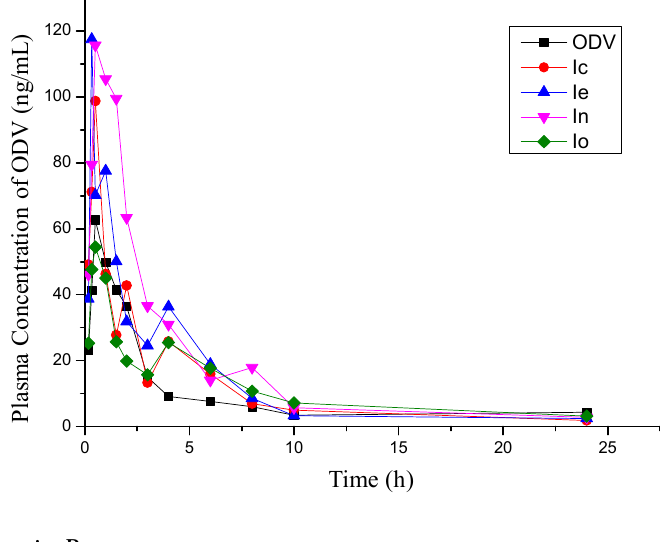
Figure 2. Plasma concentration-time profiles of ODV after administration of single oral doses (0.02 mmol/kg) of the four phenolic esters of ODV producing the highest relative bioavailability of ODV in rat (data are means, n = 4).